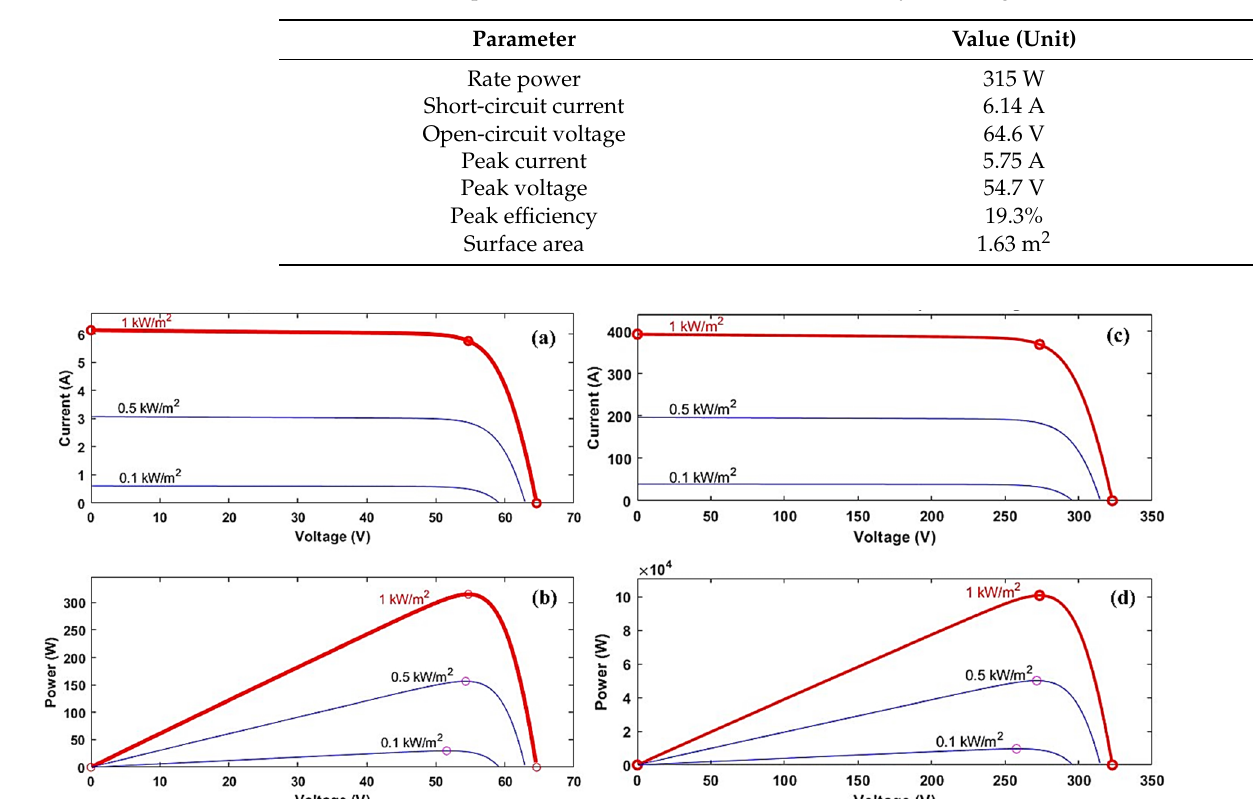
Figure 5. ( a ) I-V and ( b ) P-V characteristics of one module, ( c ) I-V and ( d ) P-V characteristics of 100-kW PV array, computed at different irradiance levels of 0.1,0.5, and 1 kW/m 2 .